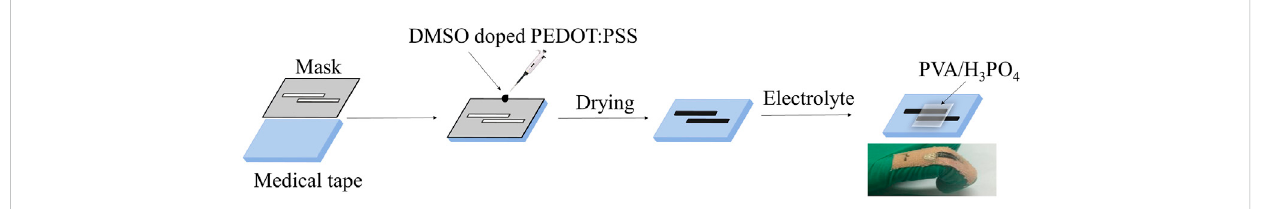
Schematic illustration of the fabrication process of the adhesive MSC.